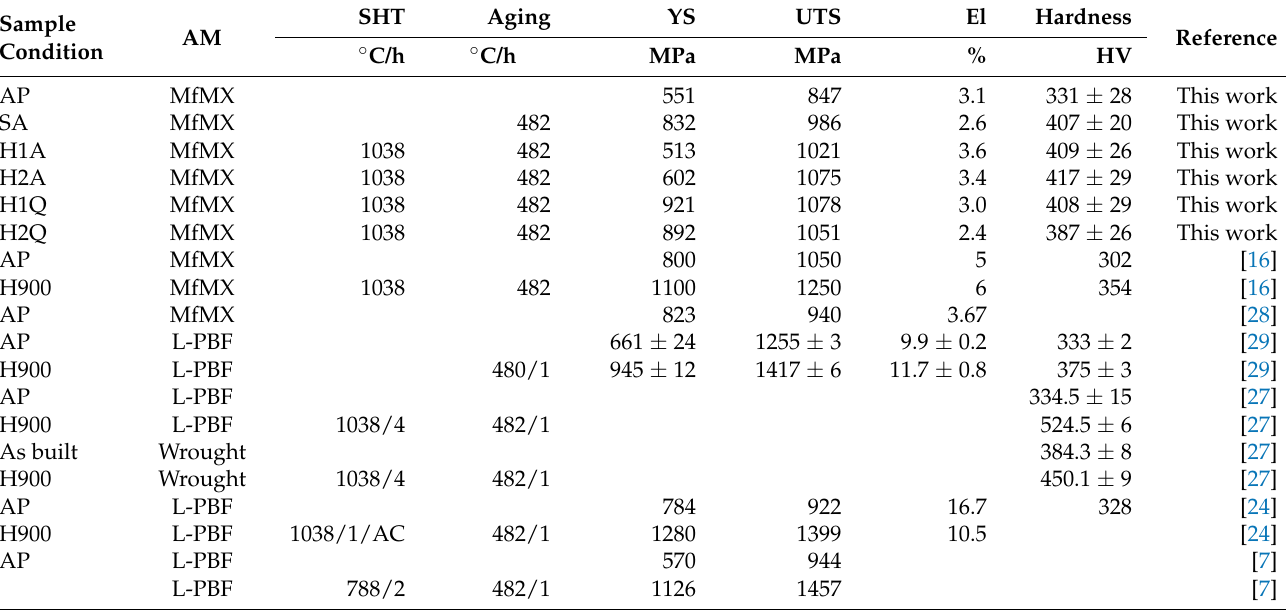
Table 5. List of tensile strengths and hardnesses compared with the